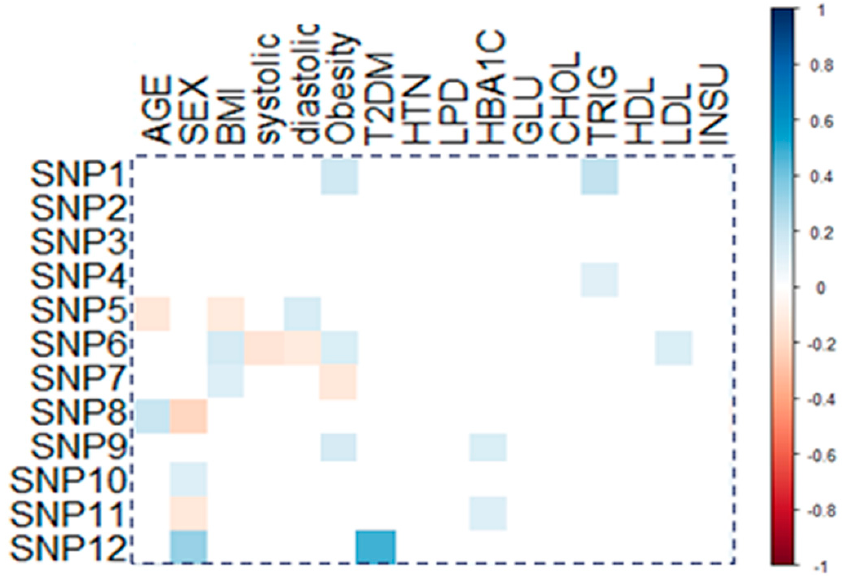
Figure 2. Correlation of genetic variants with patients’ characteristics. Correlation between gene variants and demographic/clinic-laboratory characteristics. Pearson correlation was applied, and a significant correlation coefficient is only shown. BMI: body mass index; systolic: systolic blood pressure, diastolic: diastolic blood pressure; T2DM: type 2 diabetes mellitus, HTN: hypertension; LPD: hyperlipidemia, HbA1C: glycosylated hemoglobin, GLU: glucose; CHOL: total cholesterol, TRIG: triacylglycerol; HDL: high-density lipoprotein; LDLL: low-density lipoprotein; INSU: serum insulin; SNP1: GSTM1 rs1056806, SNP2: GSTT1 rs17856199, SNP3: GSTP1 rs1695, SNP4: MGST3